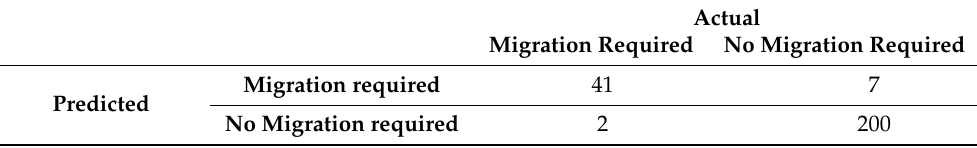
Table 4. Migration prediction rate of the second scenario simulating smart public